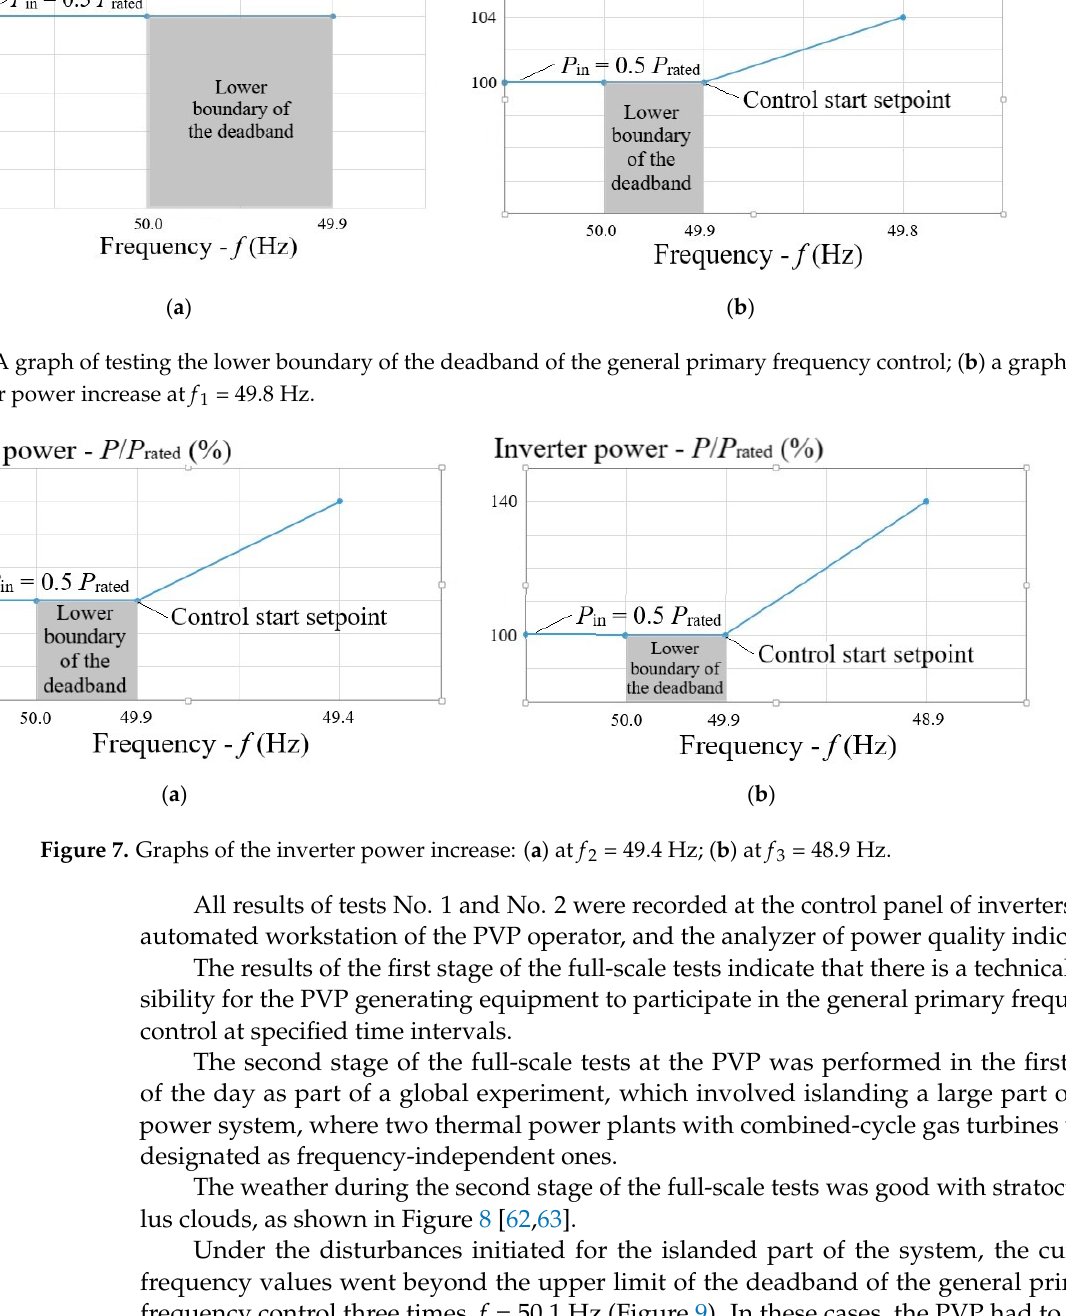
Figure 7. Graphs of the inverter power increase: ( a ) at f 2 = 49.4 Hz; ( b ) at f 3 = 48.9 Hz. 5.